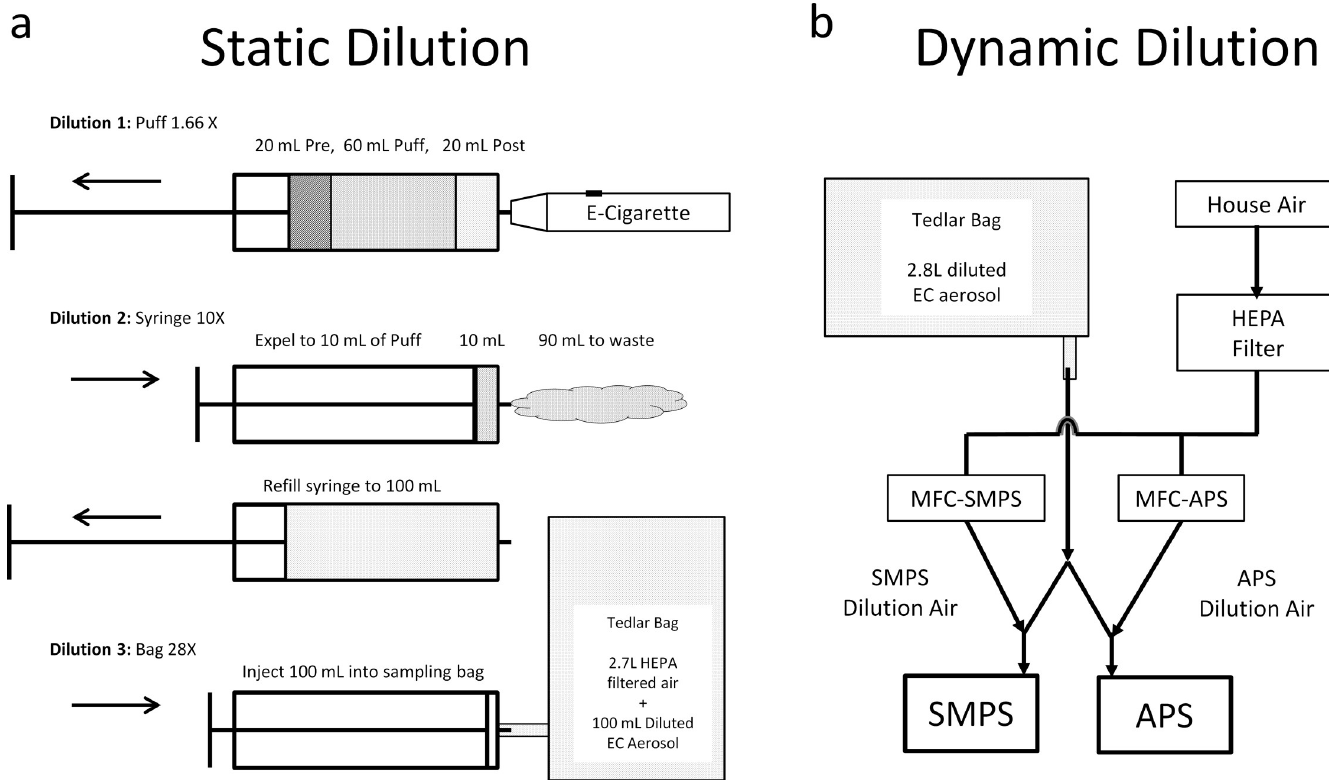
Fig 1. Experimental setup for diluting and sampling EC and cigarette aerosol. a.) Static dilution process of conducting a 60mL puff into a 100mL glass syringe, conducting a 1:10 syringe dilution then 1:28 dilution by injecting into a Tedlar bag for aerosol sampling. b.) System for dynamic dilution and characterization of aerosol by SMPS and APS simultaneously. Unique dilution rates were applied to SMPS and APS to achieve aerosol concentrations within single particle counting ranges. MFC —mass flow controller, HEPA—high efficiency particulate